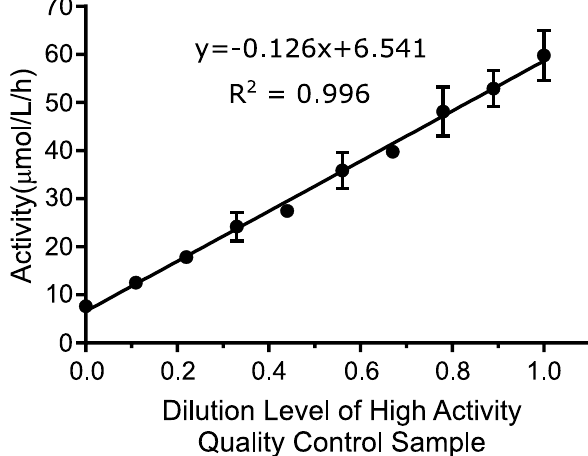
Figure 1. Linearity of the iduronate-2-sulfatase (IDS) rates of newborn screening (NBS) assay. Dilutions of the high QC samples were made in nine-step increments and plotted versus the activity detected. Four replicates were run at each dilution and the means +/− the standard deviation were graphed.